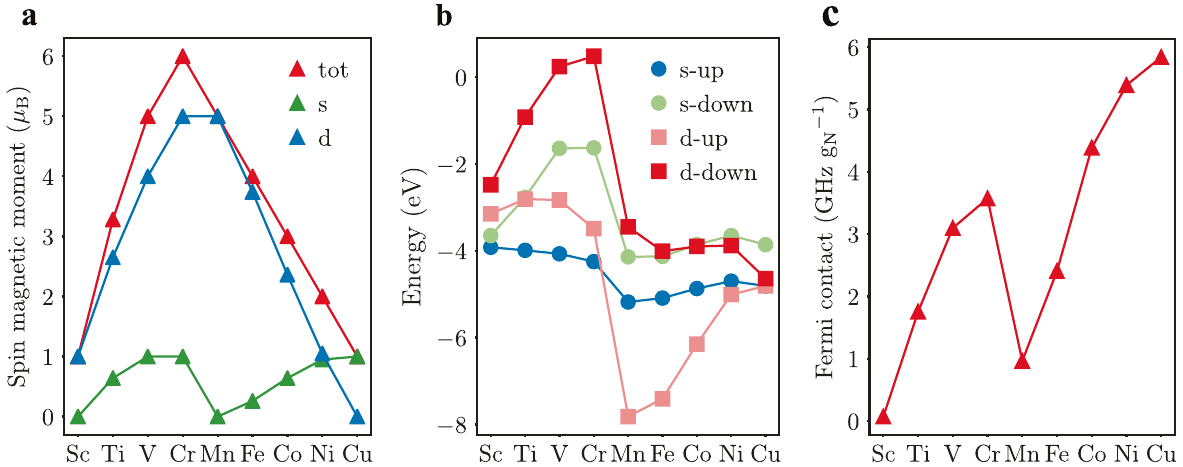
Fig. 2 Basic properties of isolated 3 d transition metal atoms. a Spin magnetic moment, b spin-polarized energy levels and c Fermi contact contribution to the hyper fi ne interaction of isolated 3 d transition metal